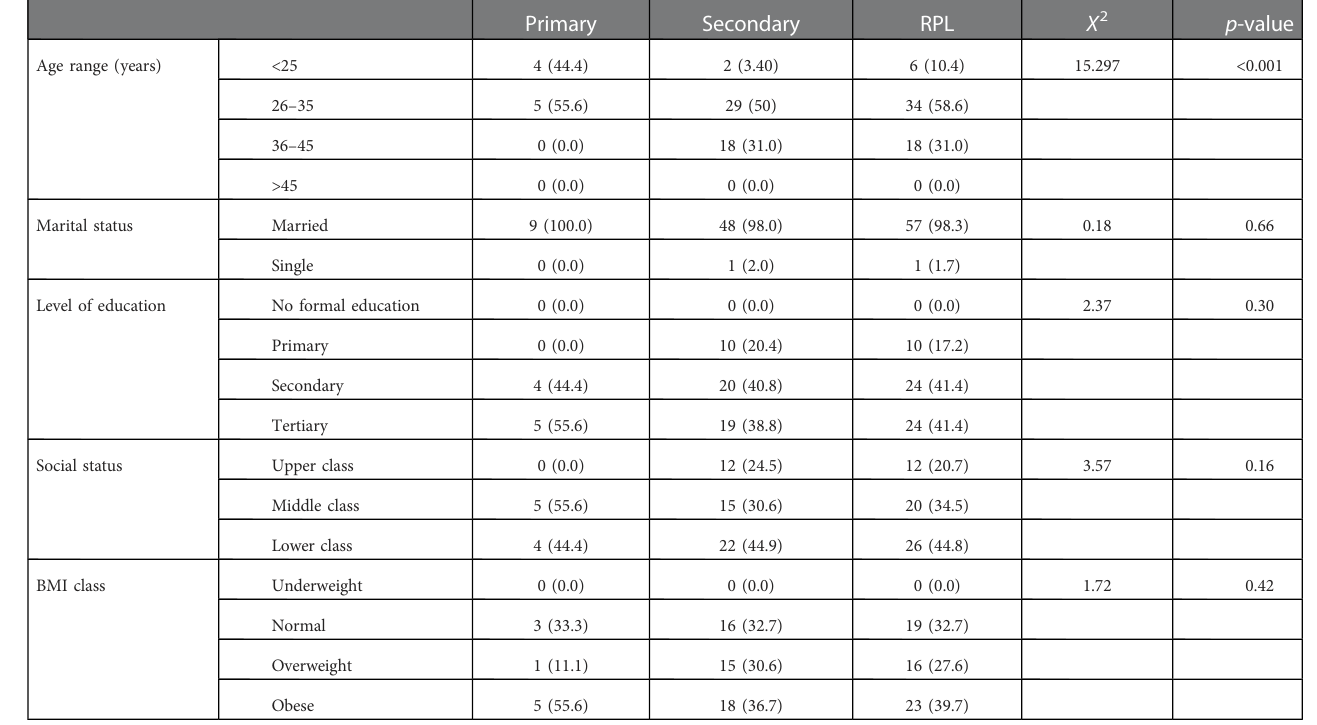
TABLE 6 Socio-demographic variables by type of miscarriage (primary vs secondary).